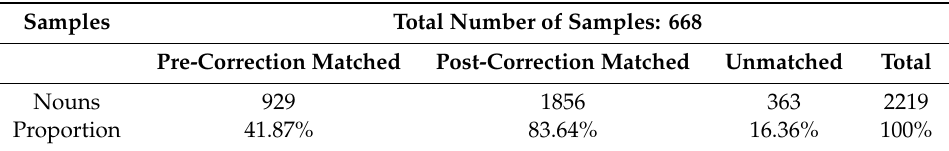
Table 6. Number of matched nouns before and after correction.